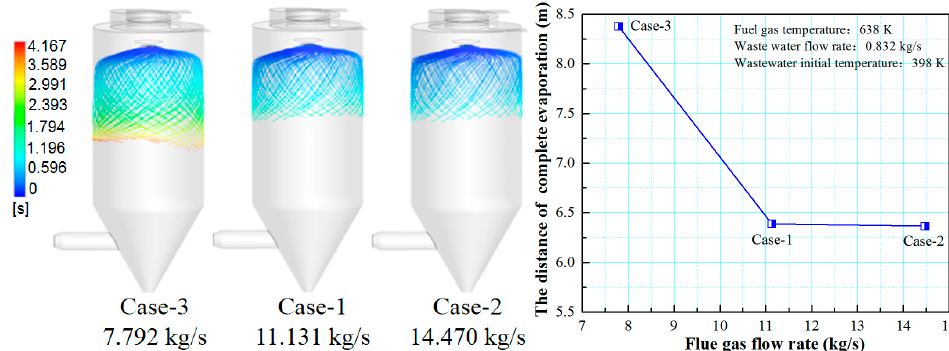
Figure 6. Effect of flue gas flow rate on evaporation performance.